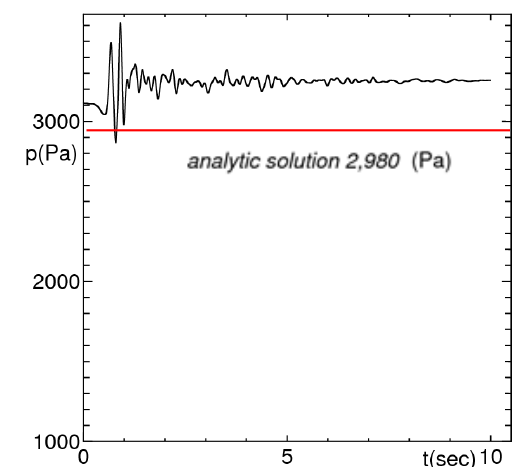
Fig. 10. Time history of static pressure at the bottom of tank.